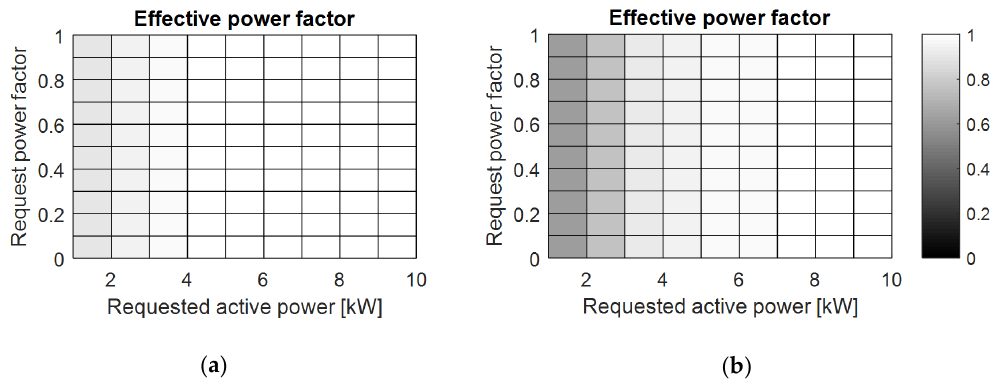
Figure 11. Effective power factor as a function of the requested active power and the requested power factor ( a ) in charging operation; ( b ) and discharging operation. The results show that the power factor control algorithm of the tested V2G charger is, in fact, nonoperational.